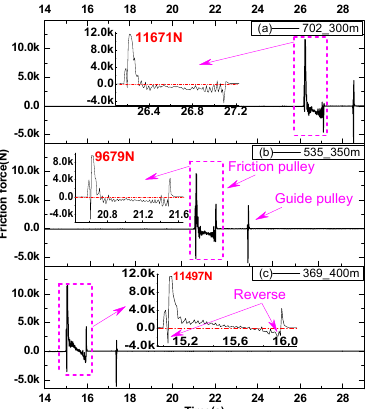
Figure 16. Friction force produced by rope wrapping the pulleys. ( a ) Rope 300 m above cage; ( b ) Rope 350 m above cage; ( c ) Rope 400 m above cage.